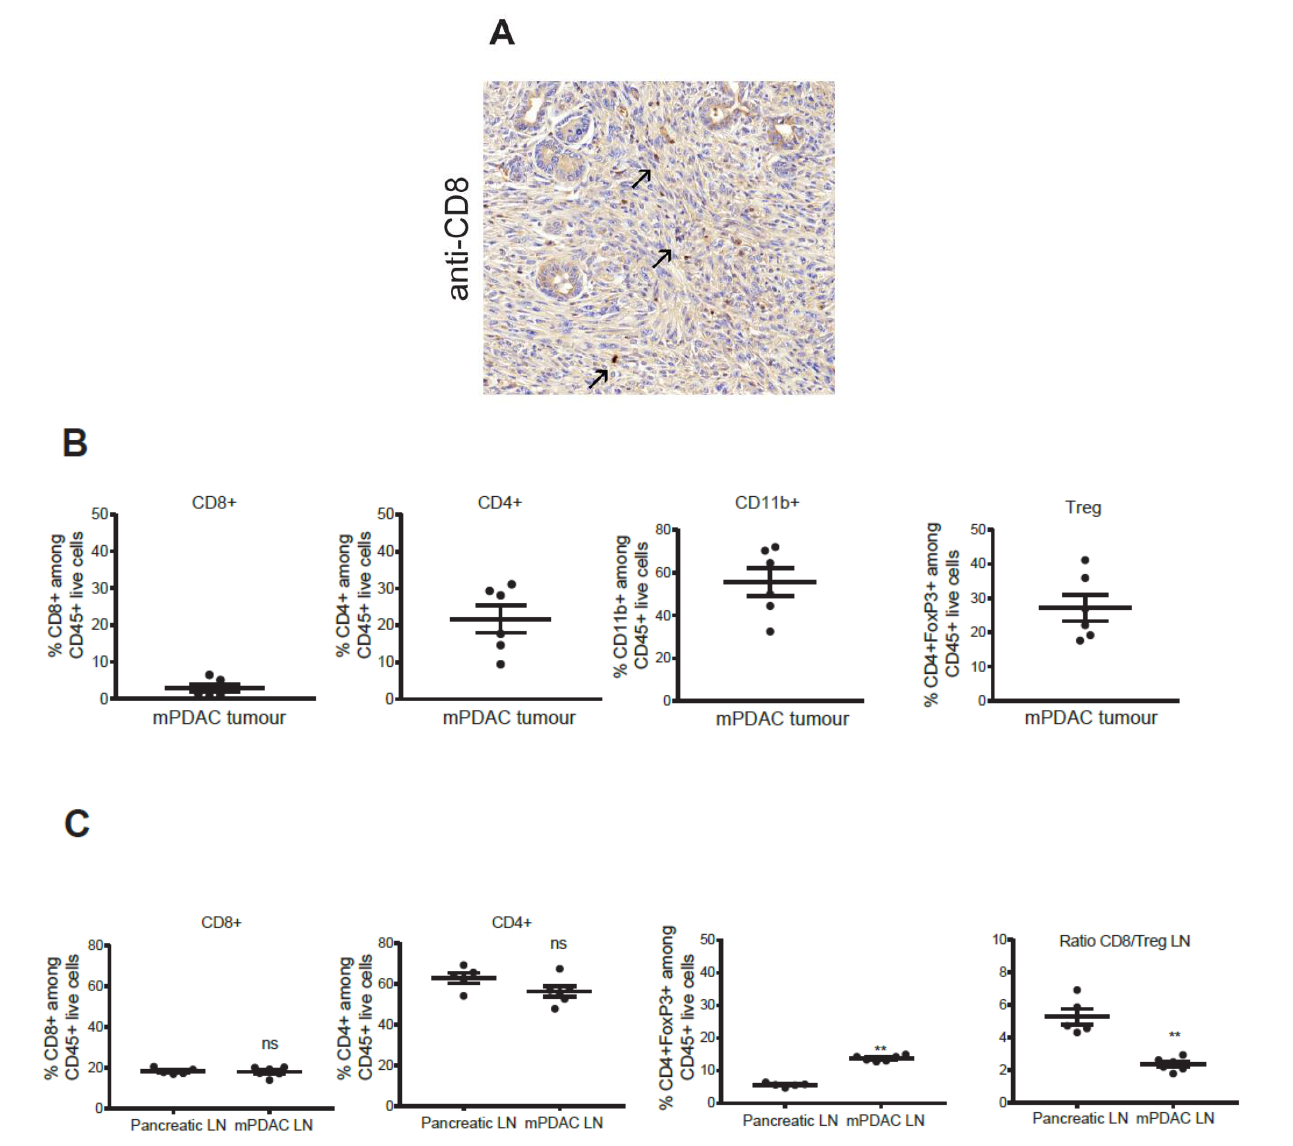
Supplementary Figure S1. Characterization of mPDAC immune microenvironment. Immuno-competent syngenic FVB/n mice were injected with mPDAC cells into the pancreas. After three weeks, mice (n = 6) were sacrificed and tumours and draining lymph nodes were collected. ( A ) Tumour sections were immunostained an anti-CD45 antibody (arrows). ( B , C ) Immune cell populations of tumours and lymph nodes were analyzed by flow cytometry and frequency were calculated among CD45 + cells. Graphs show the % of CD45 + CD8 + , CD45 + CD4 + , CD45 + CD11b + , CD45 + CD4 + FoxP3 + (Tregs among CD4 + , and the ratio of CD8/Treg in tumours. All statistical tests are Two-tailed Mann-Whitney U-test; **, p < 0.01; ns = not significant, n = 6. Scale bars 50 µ m. The authors apologize for any inconvenience caused and state that the scientific conclusions are unaffected. The original publication has also been updated.